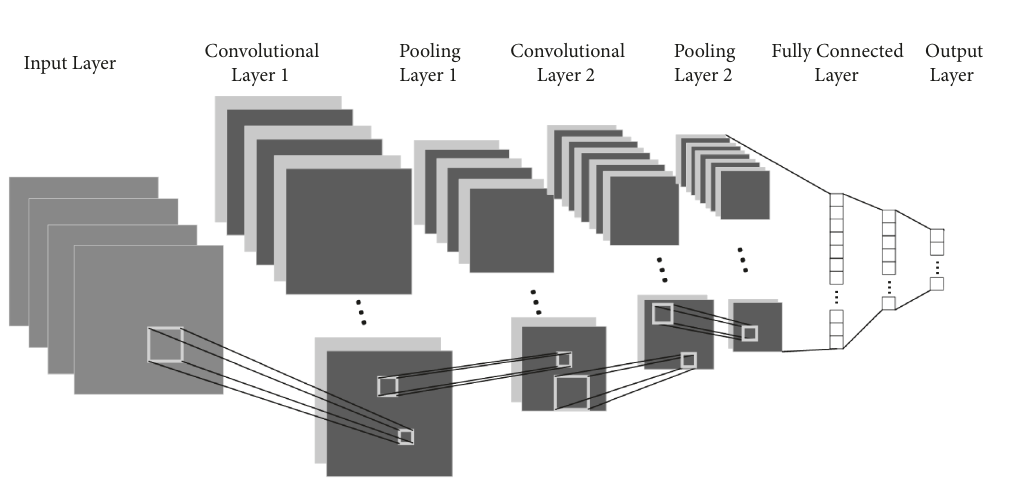
Figure 5: A typical architecture of convolutional neural network